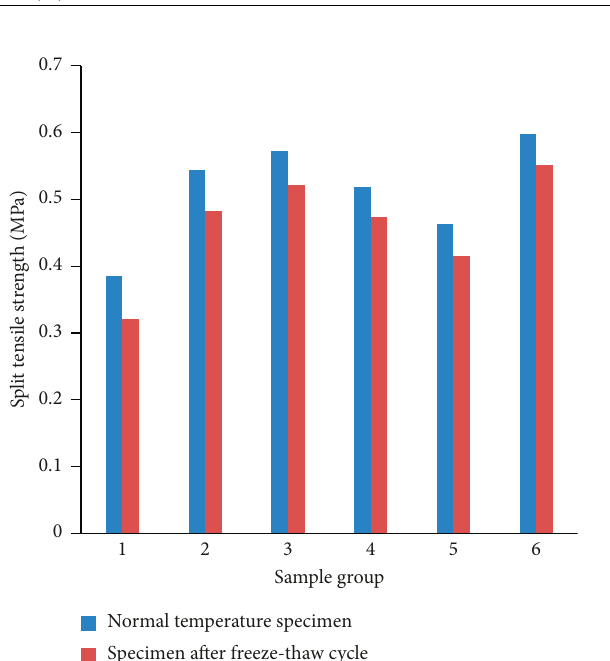
Figure 8: Vertical deformation corresponding to the maximum splitting load of each mixture specimen.